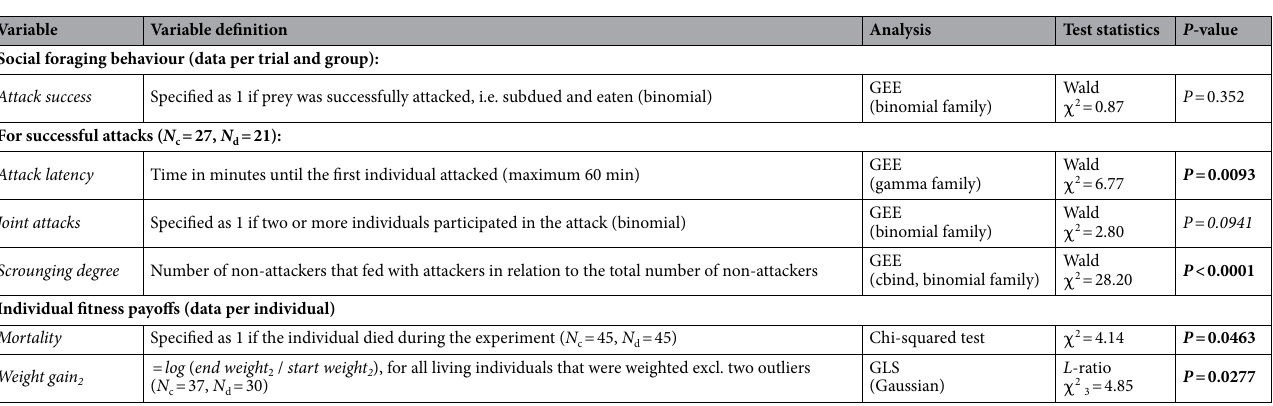
Figure 2. Group composition effects on social foraging behaviour and individual fitness payoffs. A , B : The effects of group composition (cooperative group ‘c’ or defector group ‘d’) on attack latency ( A ) and the extent of prey sharing ( B ); only successful attacks are considered (c: N = 27, d: N = 21). The boxplots show median, upper and lower quartiles and interquartile range (1.5 times). C : The effect on individual weight gain (c: N = 38, d: N = 31) presented as mean (circle) ± SE (whiskers). * indicates significant difference between group compositions (see also Table 1).